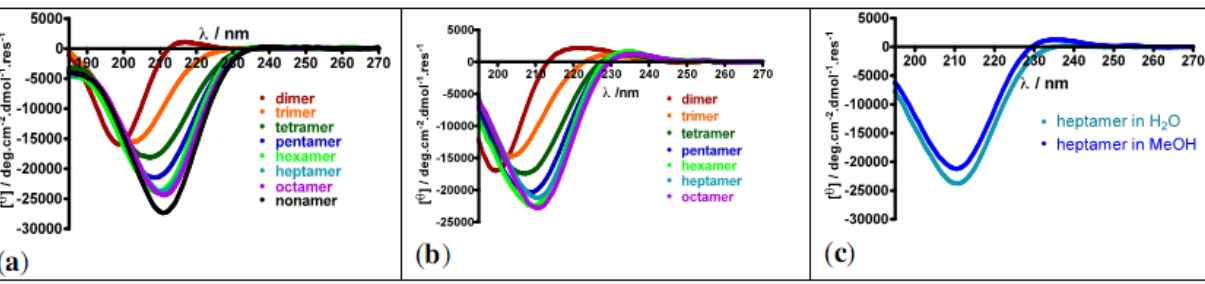
Figure 4. CD spectra of cis -prolinovaline oligomers (from dimer to octa- or nonamer) ( a ) in H O; ( b ) in MeOH; ( c ) Superimposition of the heptamer CD spectra recorded in 2 water and